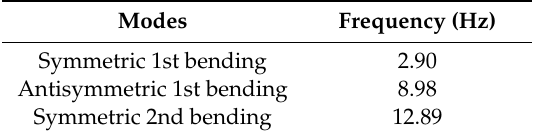
Table 3. The first three elastic modal frequencies obtained from